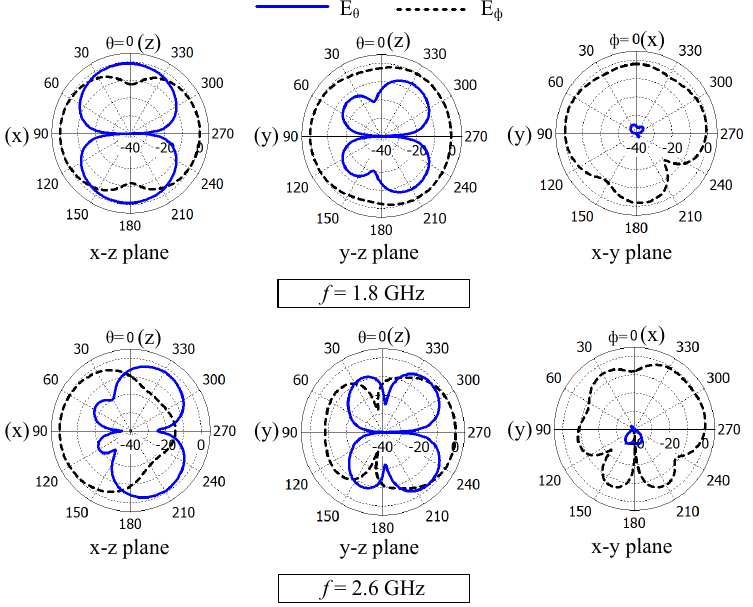
Figure 5. Normalized radiation patterns of the planar LSA antenna (Ant#1) at 1.8 and 2.6